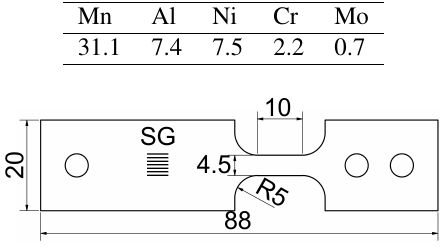
Fig. 1: Geometry of the specimens, used for all strain rates. Thickness: 2